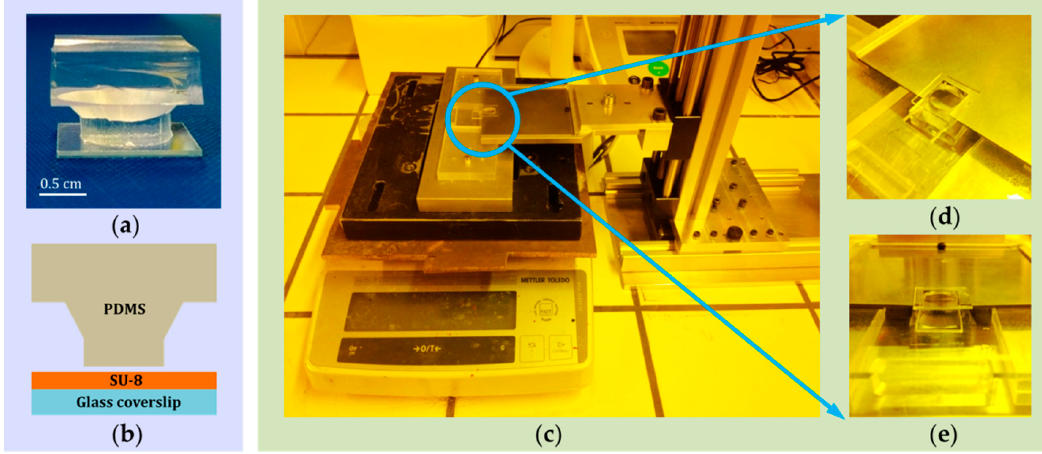
Figure 4. PDMS and SU-8 bonding testing sample ( a , b ), and the setup for the manual tensile strength test ( c – e ). ( a ) PDMS and SU-8 samples for the bonding strength test. ( b ) Schematic of the testing sample. The lower part is a piece of 1 mm thick glass coated with a 5 μ m thick SU-8. The upper part is a piece of PDMS obtained by molding. This setup ( c ) for the manual tensile strength test includes a scale, a piece of metal mass with a plastic PDMS chip fixer on top, and a lifting-arm ( c ). Detail of the manual tensile test set-up during test ( d ) and its side view ( e